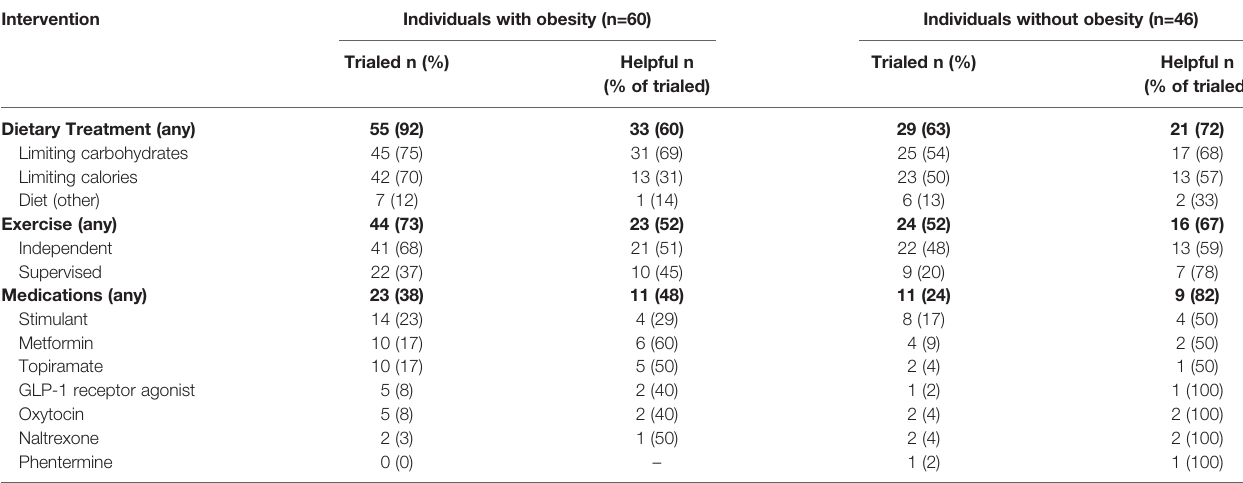
Theproportionsofcaregiverswhoreportedtrialinggivenstrategiesforweightmanagementareshown,strati fi edbycurrentobesitystatus.Ofthosewhohadtriedagivenstrategy,wealso reported the proportion who found the strategy